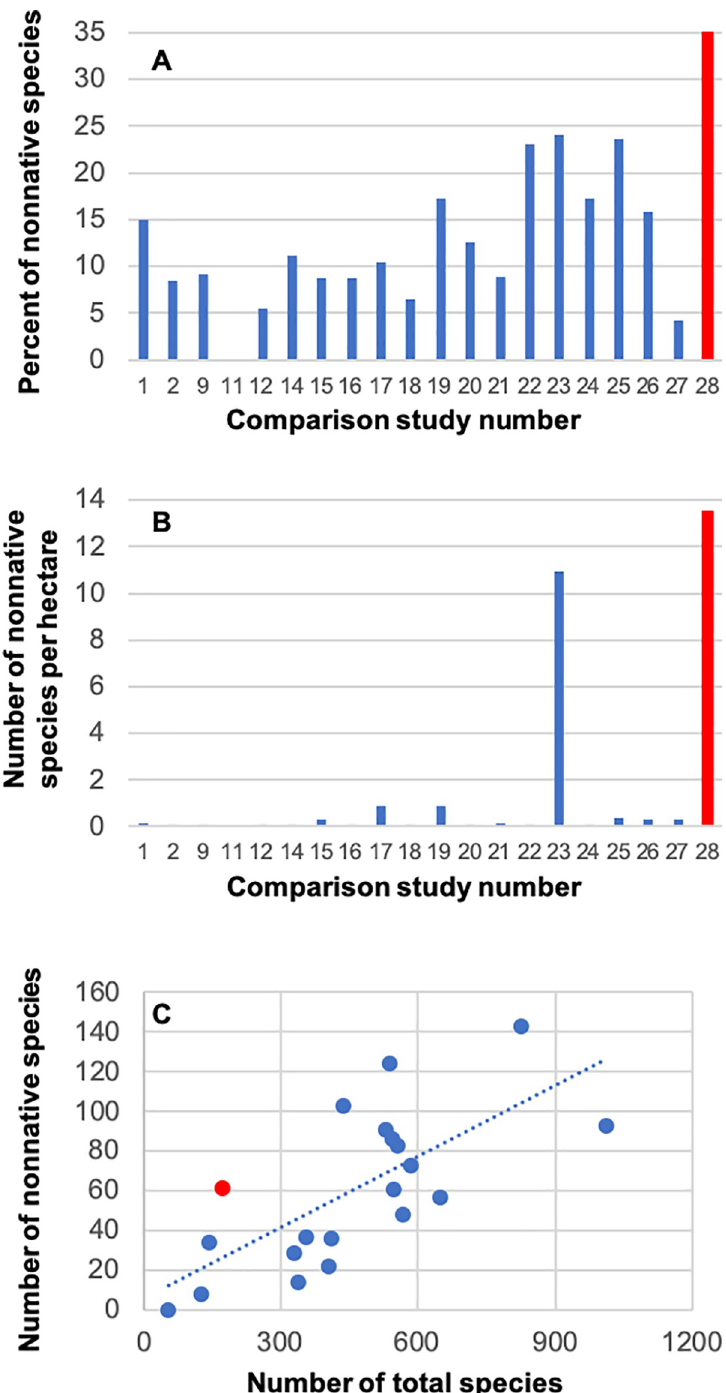
Fig 4. (A) Percent of nonnative species of the total species reported for 20 of the 28 comparison floras, (B) number of nonnative species per hectare of study area reported for 20 of the 28 comparison floras, and (C) scatterplot of number of nonnative species by number of total species reported for 20 of the 28 comparison floras. CF28 represents this study conducted at the Garden City Terminal, Port of Savannah, Georgia, USA, and bars and points are shown in red to highlight this study. Eight of the comparison floras did not directly report a number of nonnative species; therefore, they were excluded from this figure. Comparison floras 3–8, 10, and 13 are not shown.